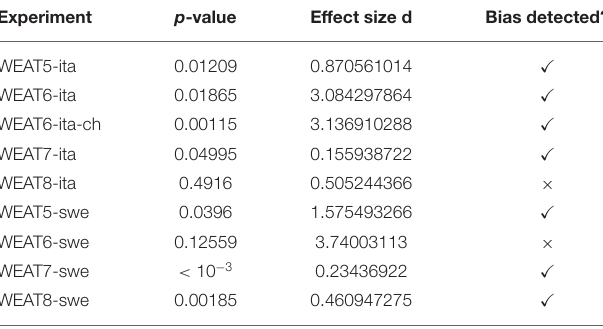
TABLE 7 | Results of the validation for Italian and Swedish. Experiment